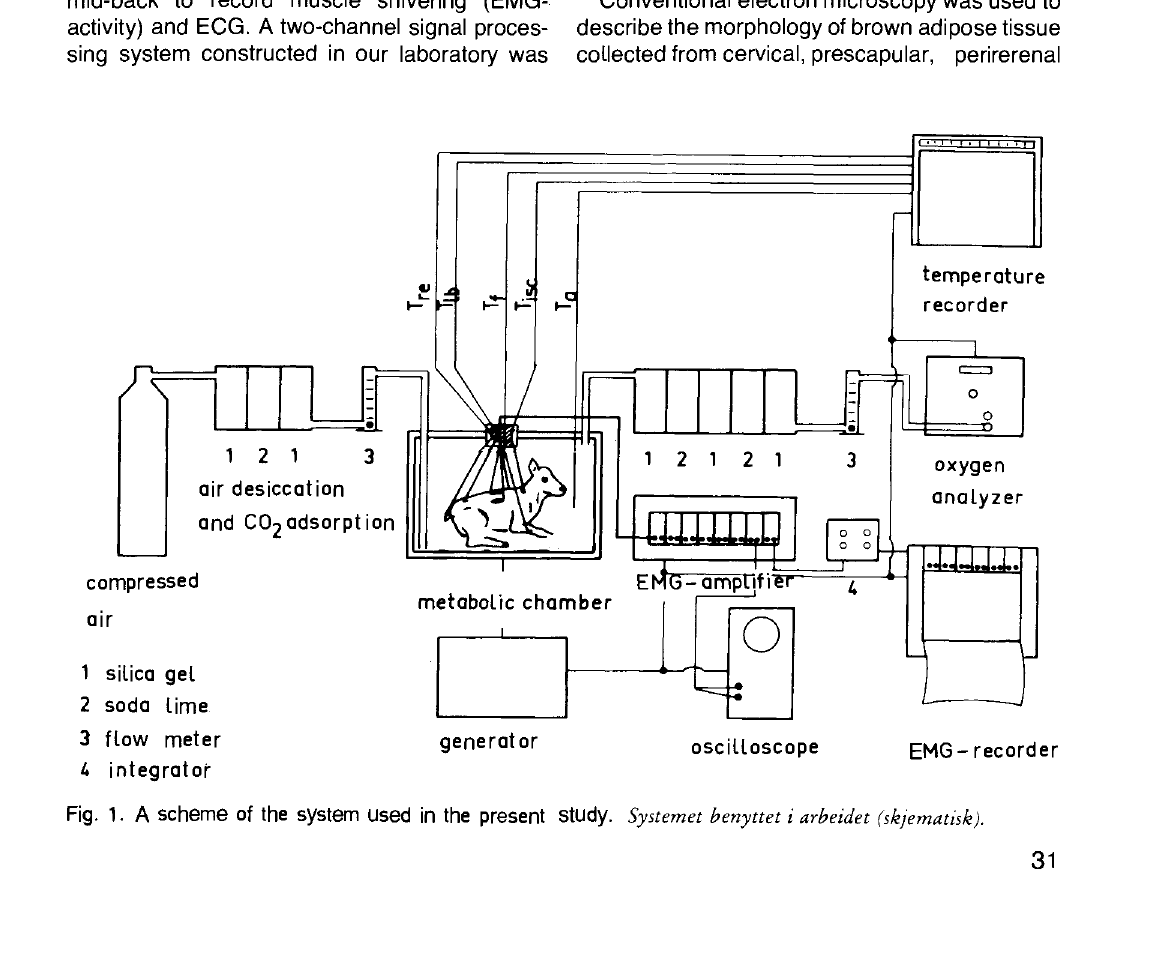
Fig. 1. A scheme of the system used in the present study. Systemet benyttet i arbeidet